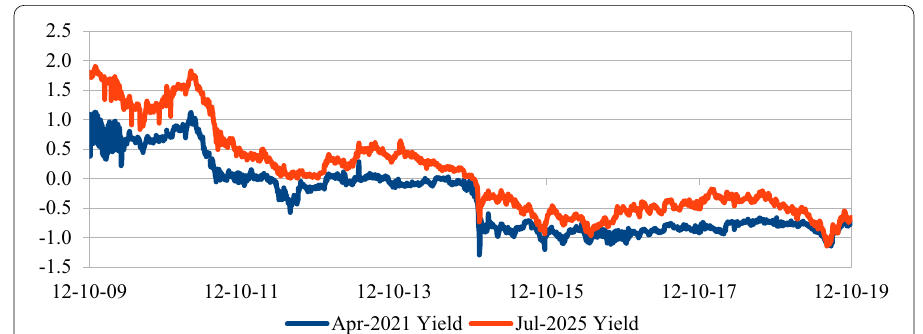
Fig. 2 CHGV Apr-2021 and Jul-2025. This figure presents the 10-year Swiss government bond yields time series. While the trend in the 2021 maturity treasuries shows decreasing yields from 2021 until early 2015, the opposite happens on the 2025 maturity treasury yield trend for the period after the currency price shock. Source : EIKON